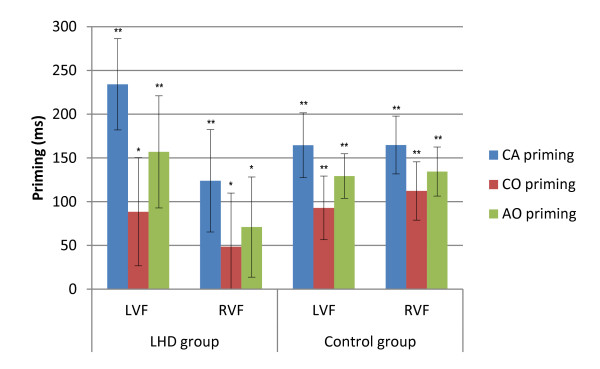
Reaction time priming effects for LHD and Control groups in the two-word memory condition. Illustrated priming effects represent the mean of individual priming effects in milliseconds (Unrelated - Related condition RT) for each condition. Error bars represent +/- 1 Standard Error. LHD = Left hemisphere damage group; Control = Control group; CA = Category Association; CO = Category Only; AO = Association Only; UNR = Unrelated; LVF = Left visual field; RVF = Right visual field; SOA = stimulus onset asynchrony; * p ≤ .05; ** p ≤ .001.